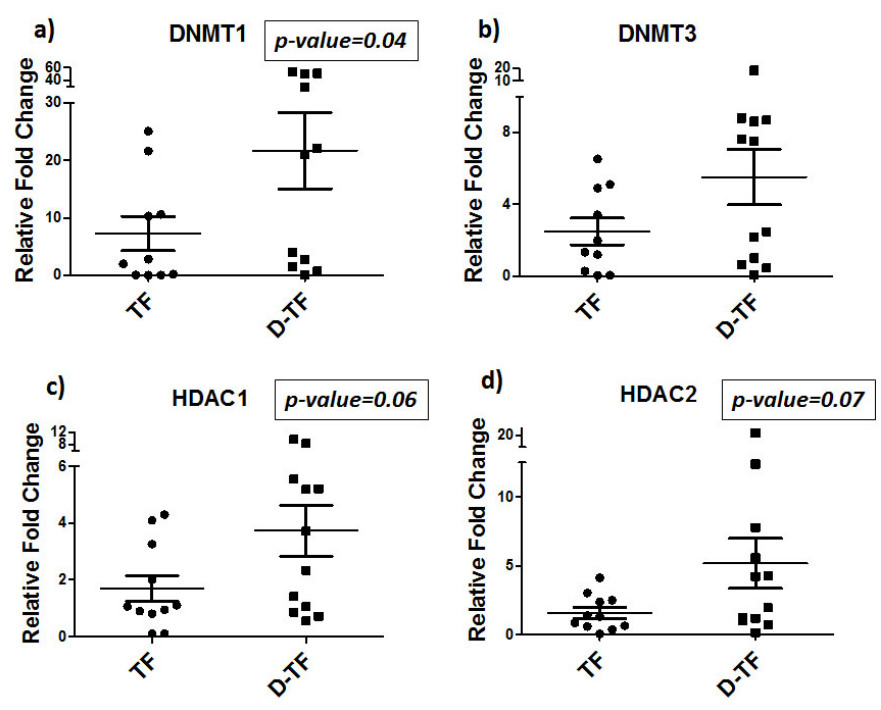
Figure.4: Methylation related genes dysregulated in diabetic trigger finger samples. ( a ) DNMT1, ( b ) DNMT3, ( c ) HDAC1, and ( d ) HDAC2 gene expression level dysregulated in diabetic trigger finger (D-TF) samples compare to trigger finger (TF) *P<.05, , # P<.001